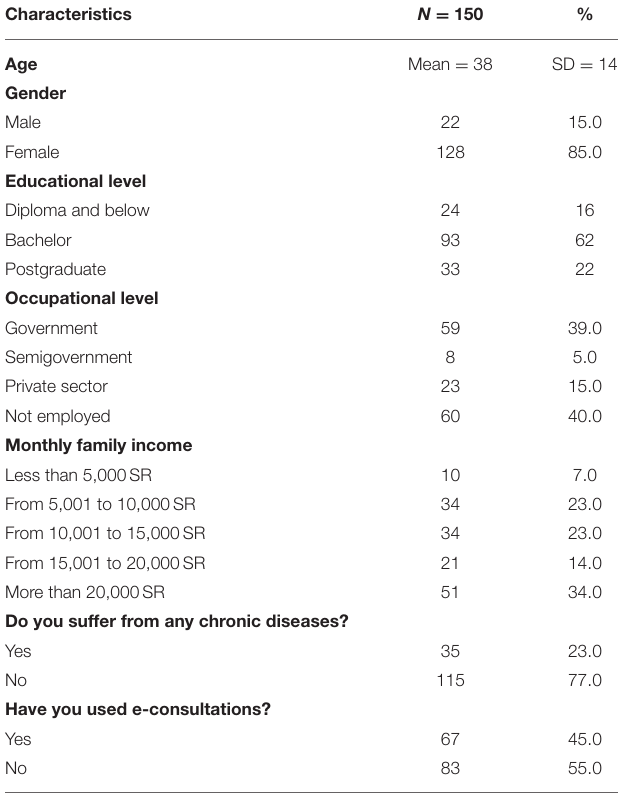
TABLE 1 | Study sample external